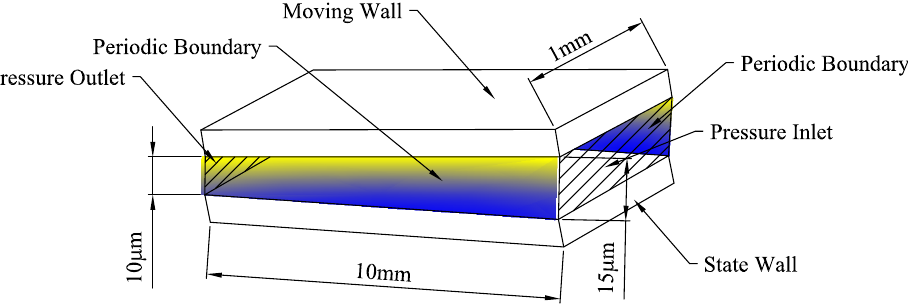
Figure 5. Schematic diagram of slider bearing